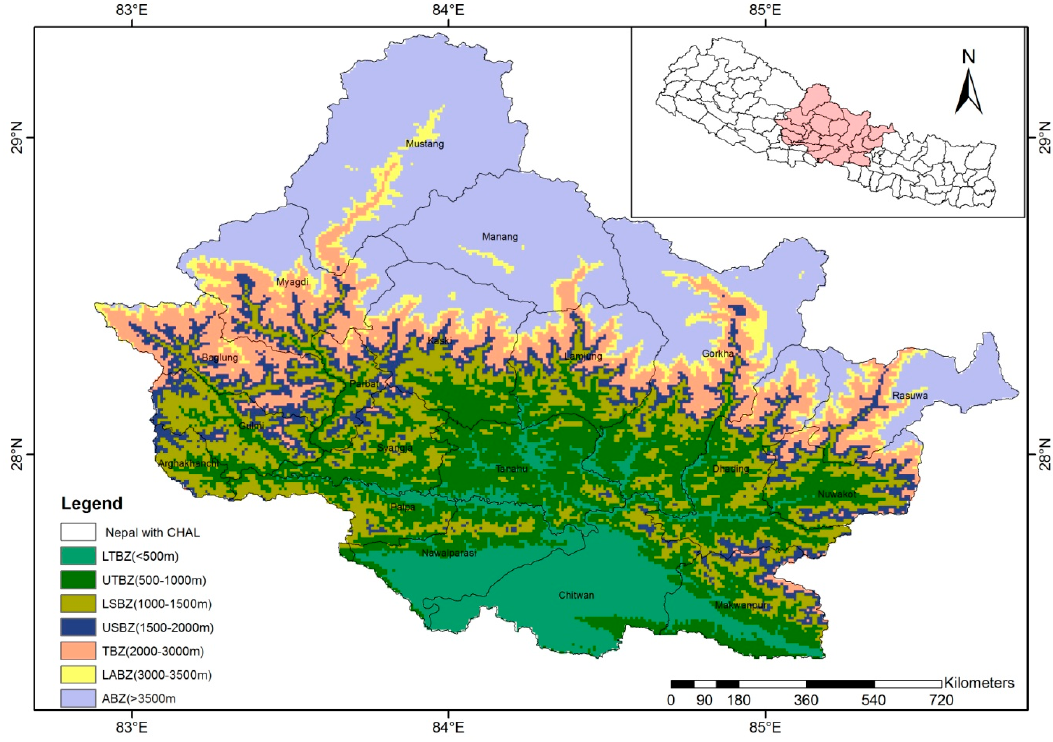
Figure 1. Map of CHAL area with different bioclimatic zones.